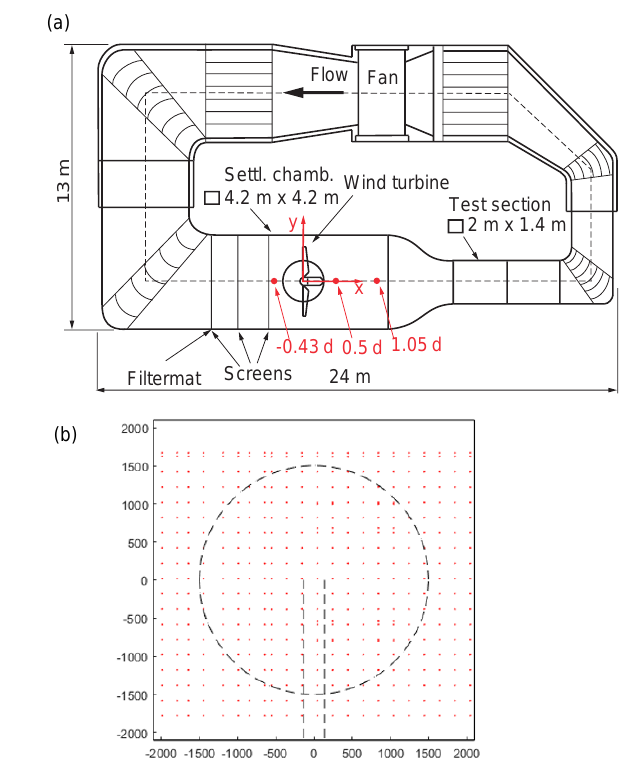
Figure 2. Large wind tunnel of TU Berlin ( a ) and hot-wire mea- surement position in each cross plane ( b ) (Bartholomay et al., 2017). The dashed lines in the lower picture indicate the rotor and the tower.